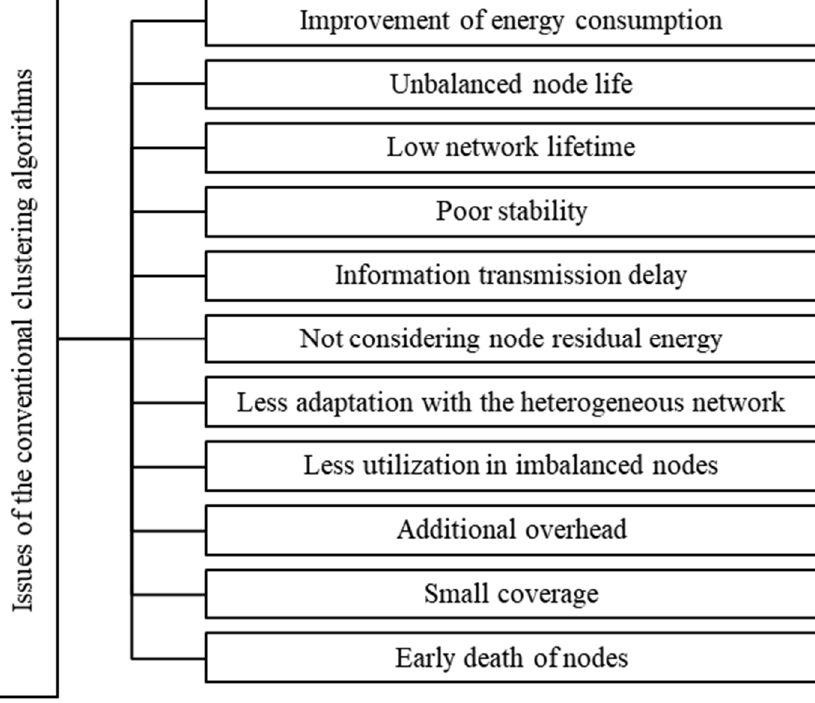
Figure 3. Issues of clustering protocols.